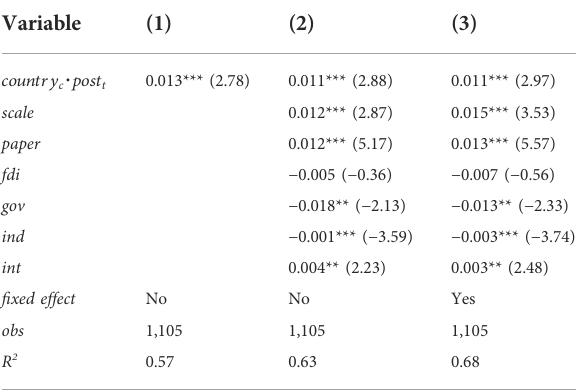
TABLE 2 Results of the benchmark empirical.